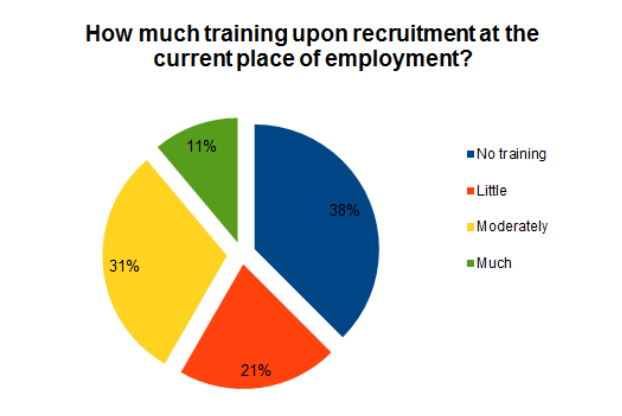
Figure 15 - Training at the current place of